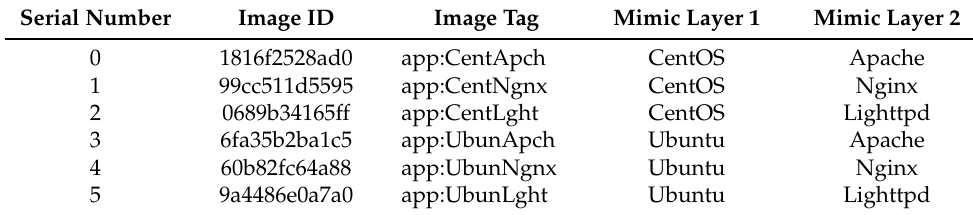
Table 3. Mapping relationship between mimic images and mimic